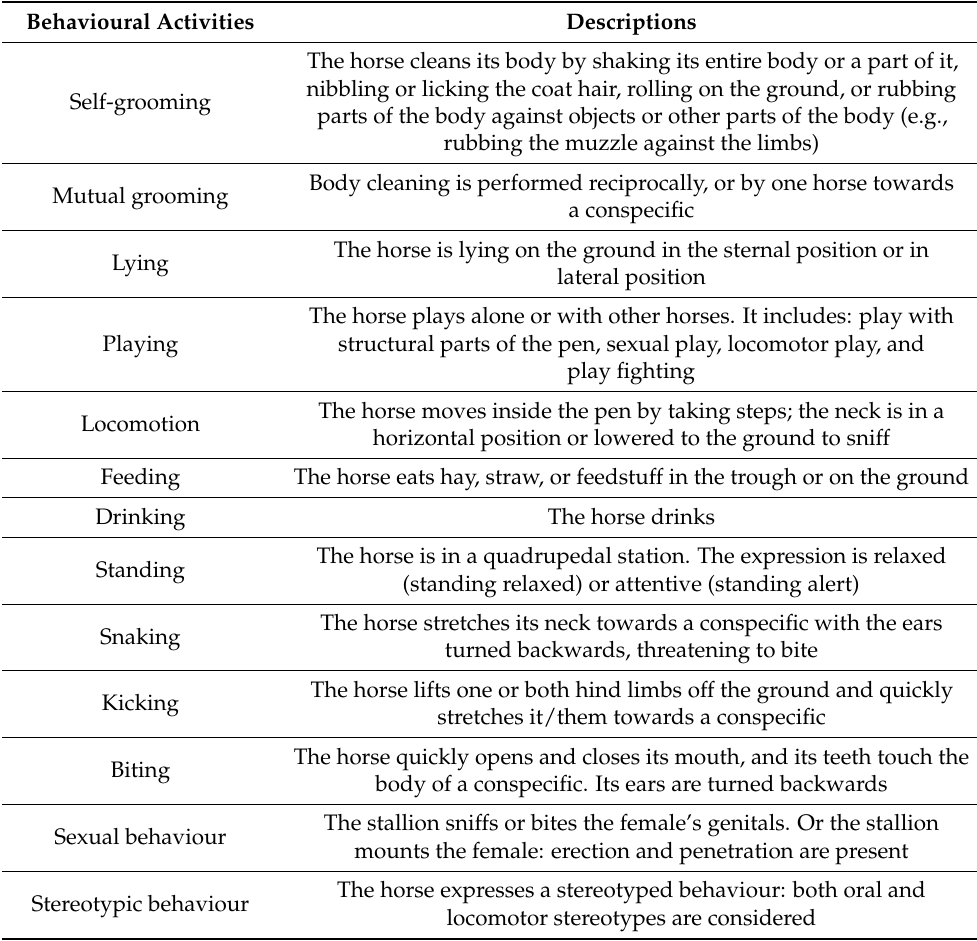
Table 1. Descriptions of the evaluated behavioural activities. Adapted from Raspa et al. [20]. Behavioural